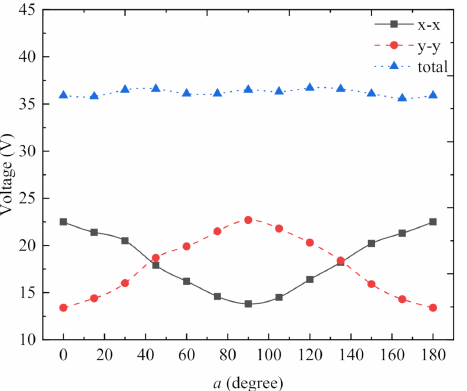
Figure 11. Output voltage for multidirectional vibration of the